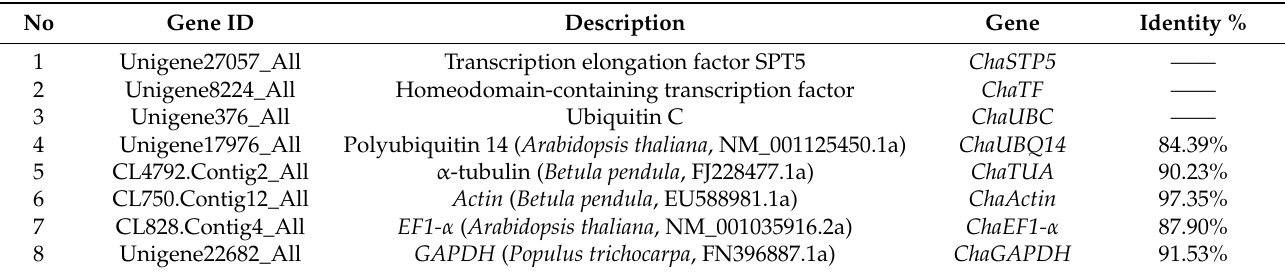
Table 1. Eight candidate reference genes.